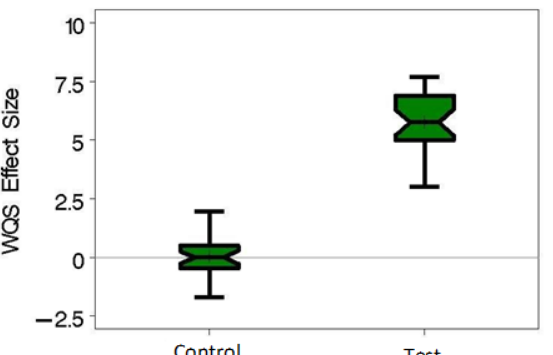
Figure 2. Simulated Variable Associations with the Human Gut Microbiome. Box plots show the beta coefficients estimated as the association between the human gut microbiome and the simulated test and control variables, using weighted quantile sum regression with random subsets and 30 repeated holdouts. Associations with error bars that do not cross 0 are considered statistically significant. Data come from the Human Microbiome Project I with simulated test and control variables. Abbreviations: Weighted Quantile Sum Regression (WQS).